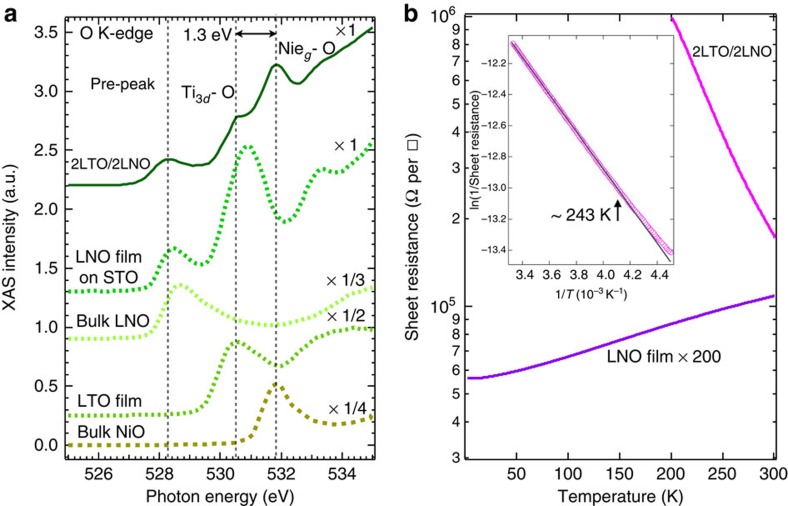
Oxygen K-edge spectra and electrical transport of 2LTO/2LNO.(a) Normalized XAS spectra at O K-edge. The black dashed lines indicate the assignments of three key features: the pre-peak (∼528.5 eV) and hybridized Ti 3d-O (∼530.5 eV) and Ni eg−O (∼531.8 eV) states by comparing with the spectra of four reference samples LaNi3+O3 film (10 u.c. on SrTiO3 substrate), bulk LaNi3+O3, LaTi3+O3 film (20 u.c. on TbScO3 substrate59) and bulk Ni2+O (the data of NiO was adapted from ref. 60). (b) Temperature-dependent sheet resistances of the SL 2LTO/2LNO and the reference LaNiO3 film (20 u.c.). It is noteworthy that the sheet resistance of LNO film is × 200. Inset: resulting fit of the conductance of 2LTO/2LNO (black solid line) yielding an activation gap Eg1∼0.2±0.01 eV (ref. 61).